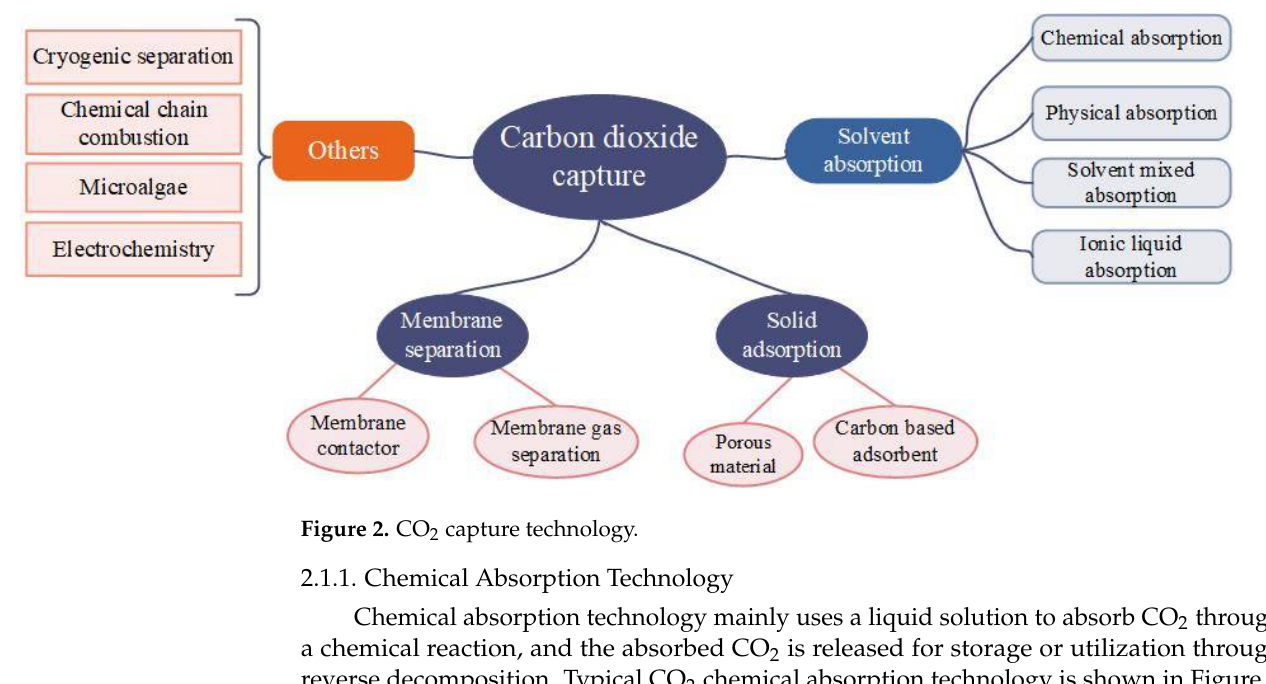
Figure 2. CO 2 capture technology.